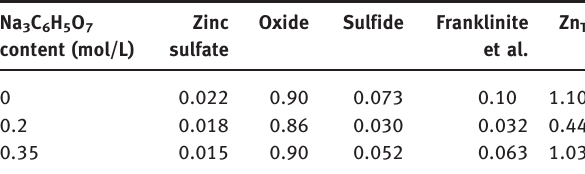
Table 4: Zinc phase of leaching slags (mass fraction,